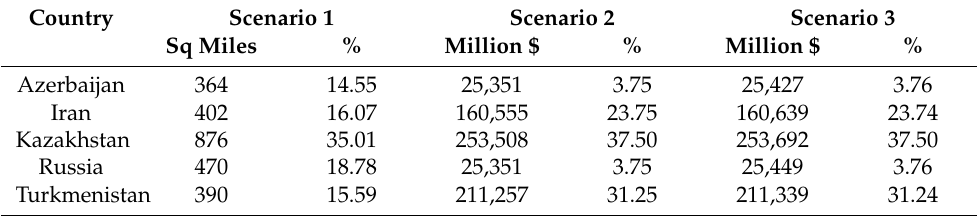
Figure 2. Spatial distribution of the oil and gas resources of the Caspian Sea (Caspian Sea NSS [43]). Table 1. Countries’ non-cooperative shares for each proposed scenario .